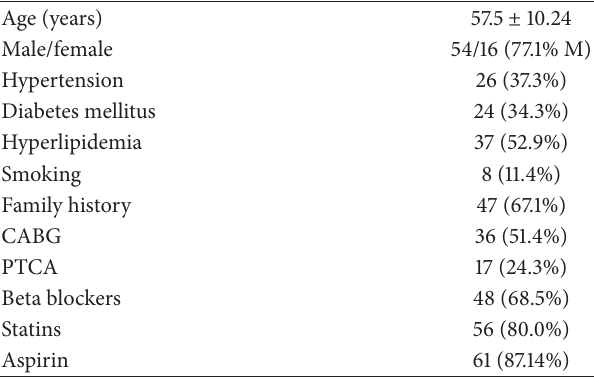
Table 1: Demographic data of the patients.